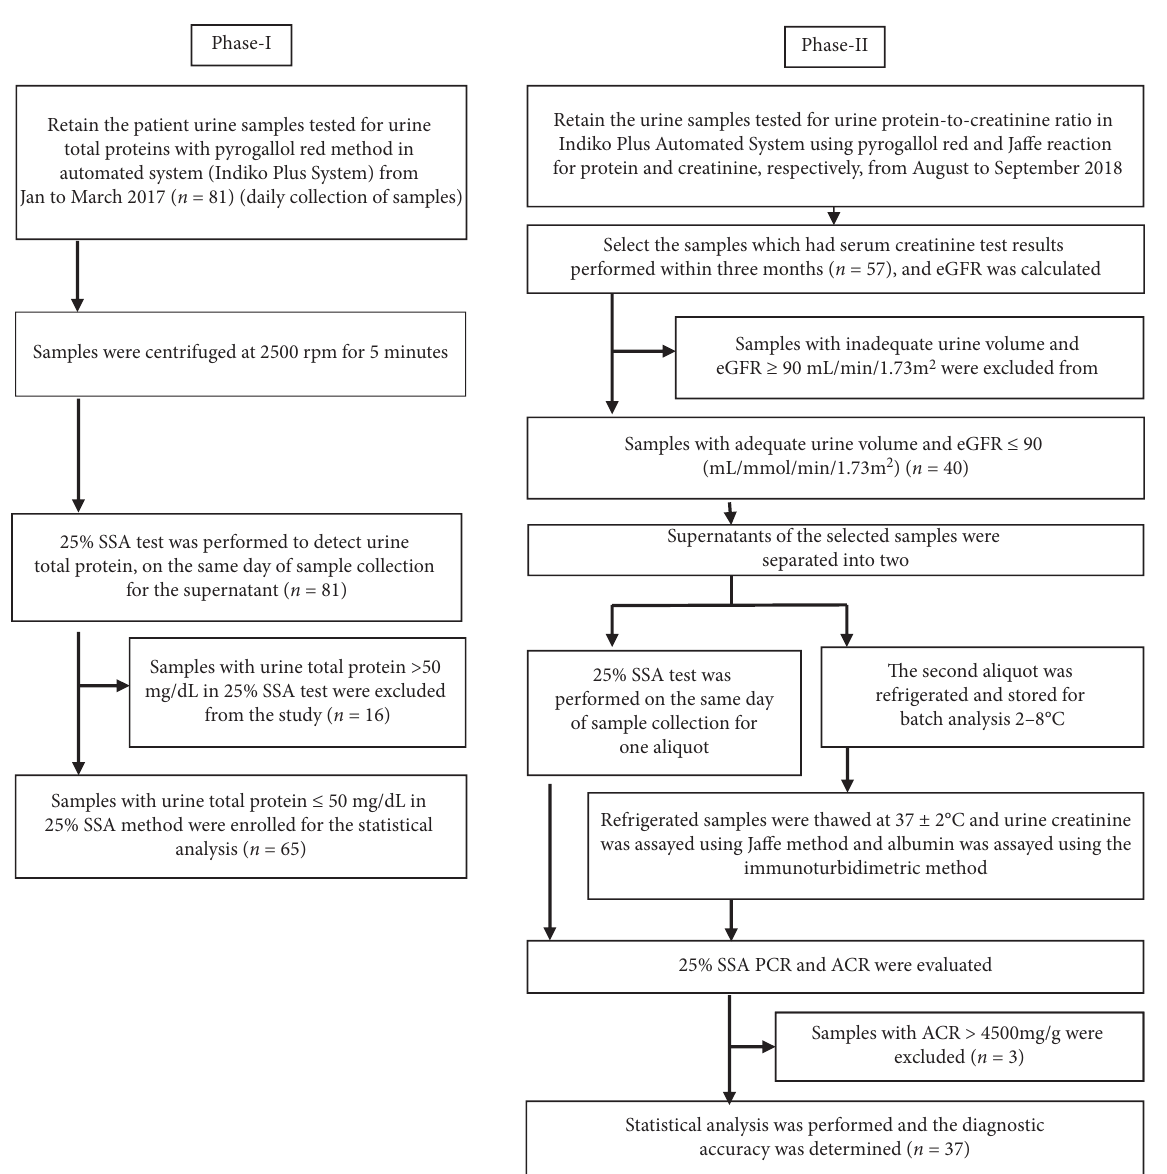
Figure 1: Flow diagram of the study.